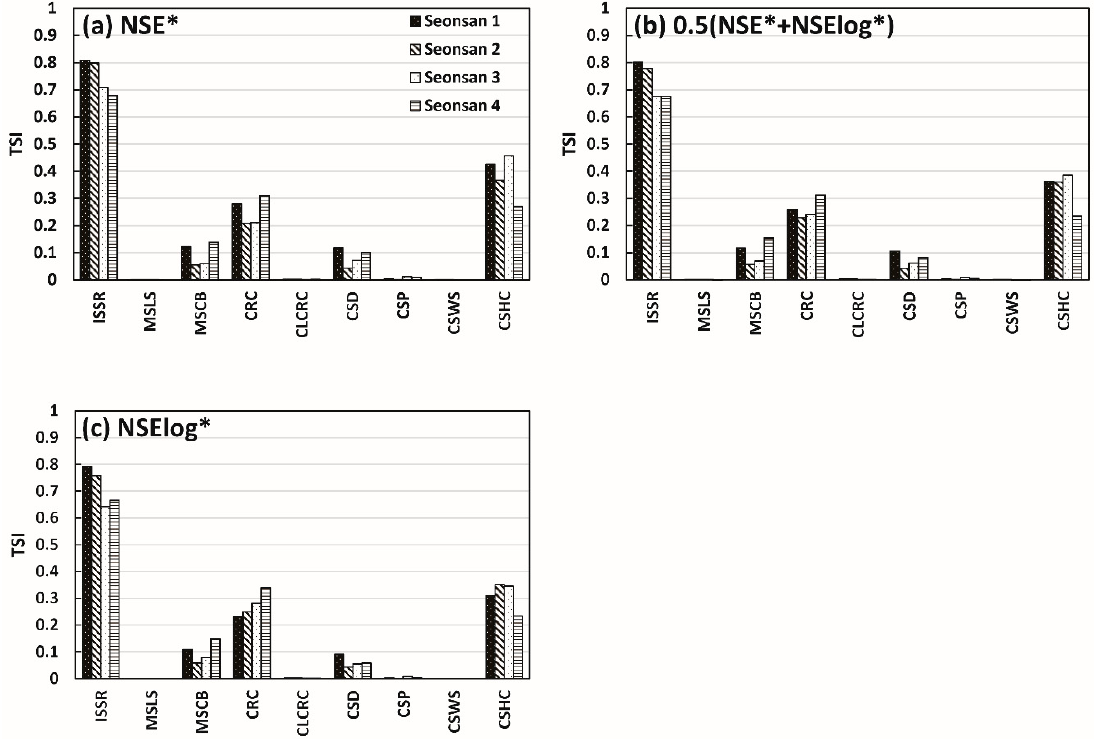
Figure 5. Parameter sensitivity of rainfall events in Seonsan catchment, calculated for three objective functions: ( a ) NSE*; ( b ) 0.5(NSE* + NSElog*); ( c ) NSElog*.